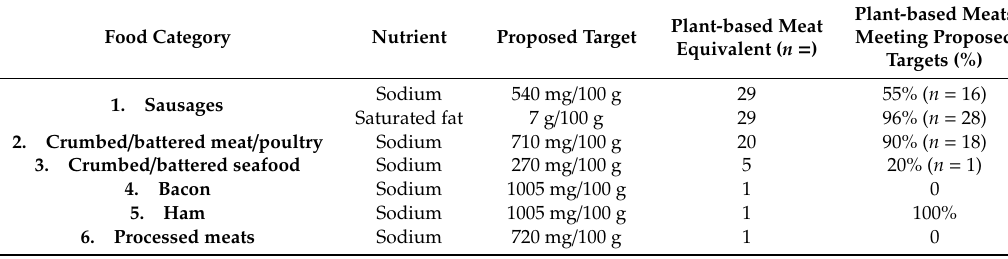
Table A1. Comparison with Healthy Food Partnership proposed reformulation